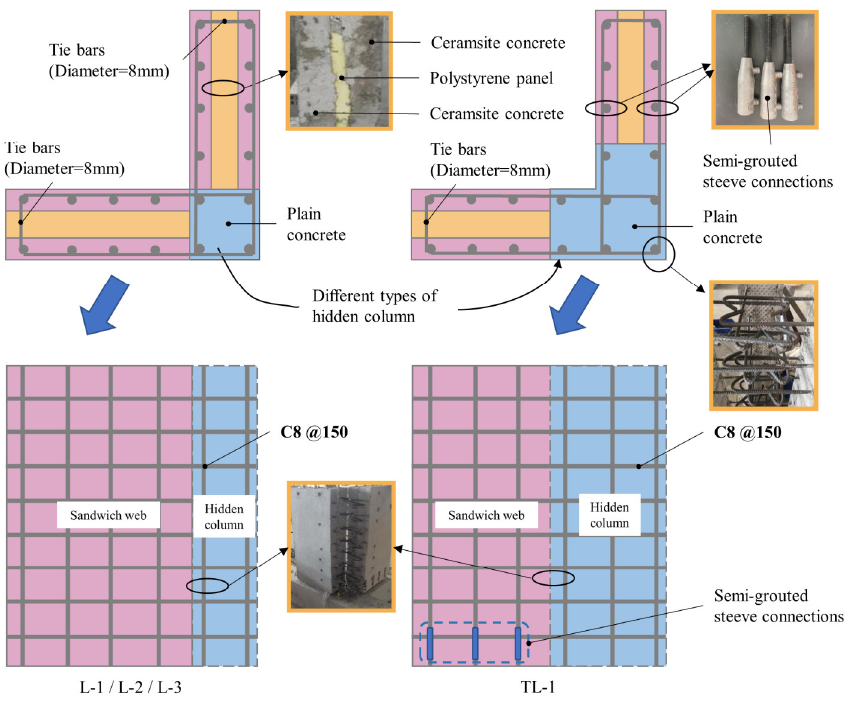
Figure 2. Geometric size and rebar arrangement of the specimens. (Unit of mm).